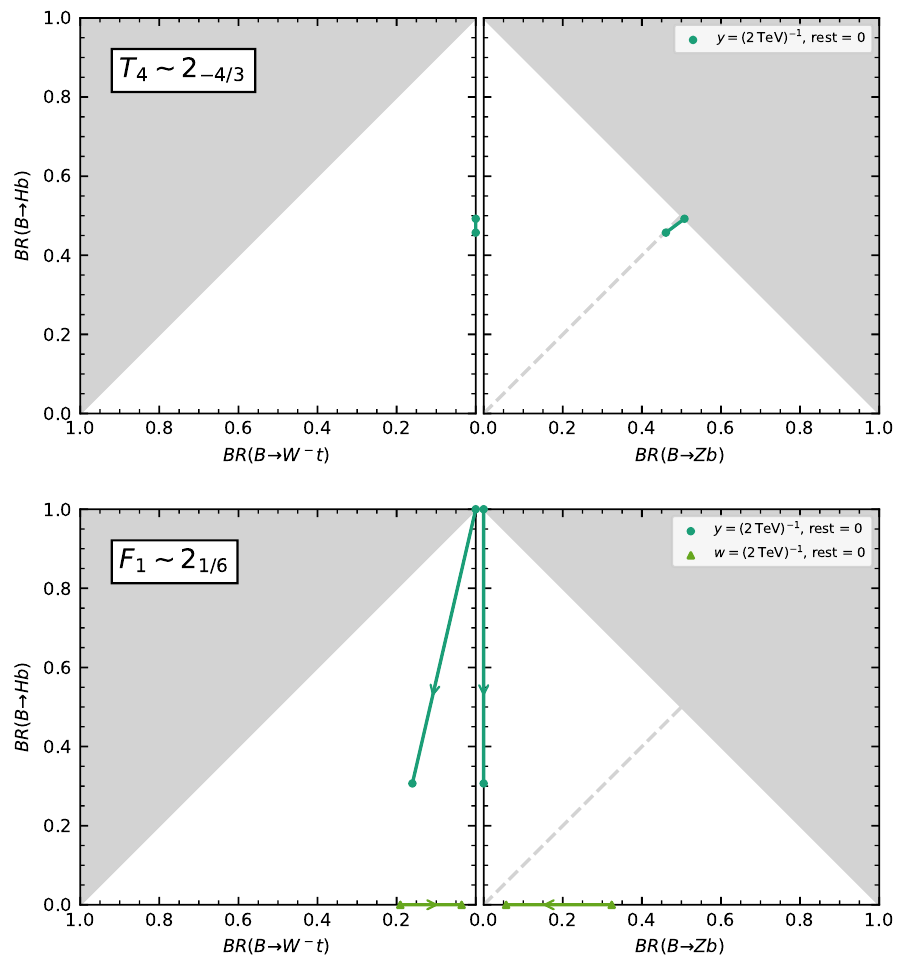
Figure 16 . Branching ratios of B into Hb , Zb and W (cid:0) t for various values of the parameters in the T 4 and F 7 models.